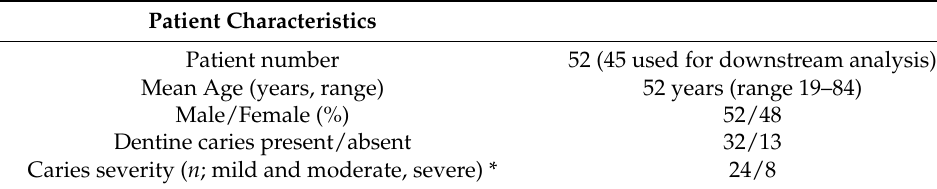
Table 1. Clinical data on dental patient cohort used in this study ( n =